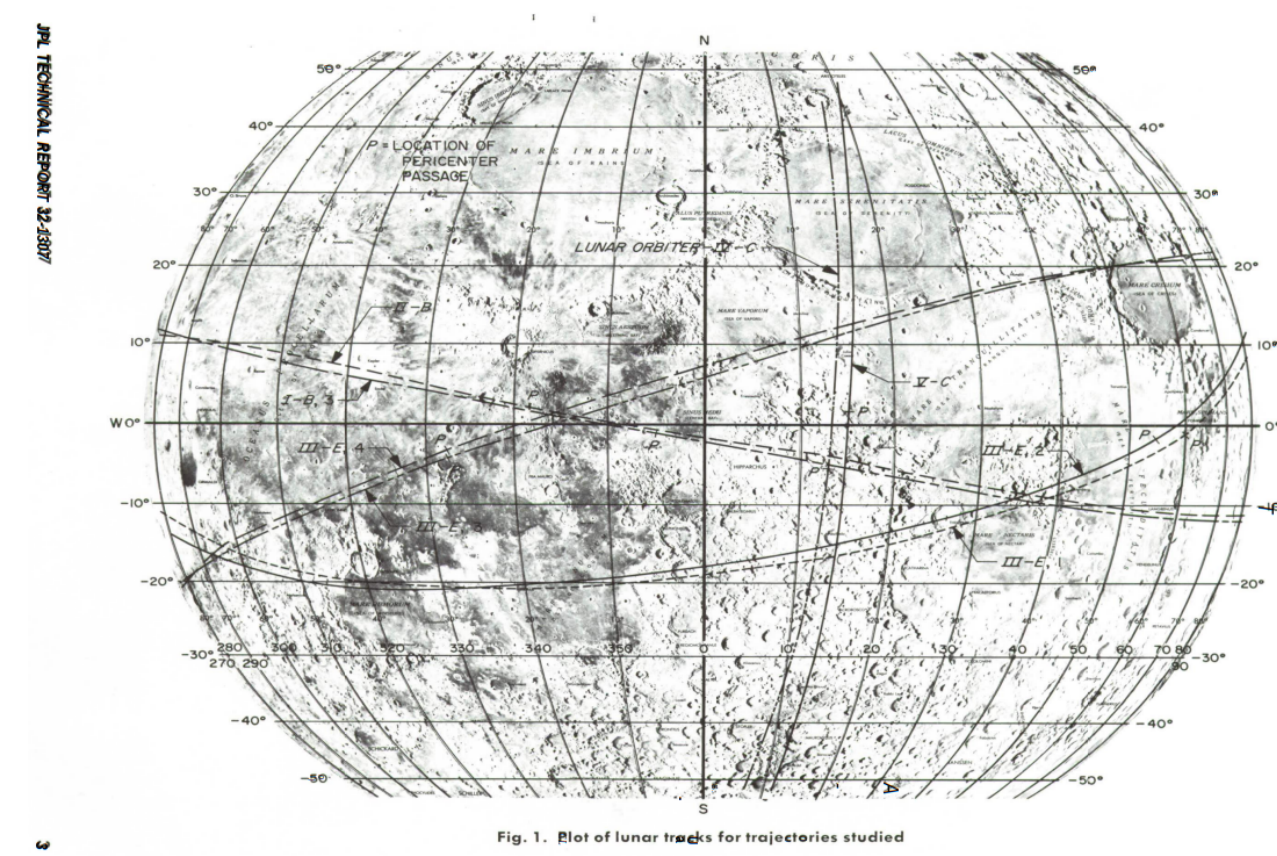
Figure 1. Lunar maria and selected tracks of the Lunar Orbiter given in Muller